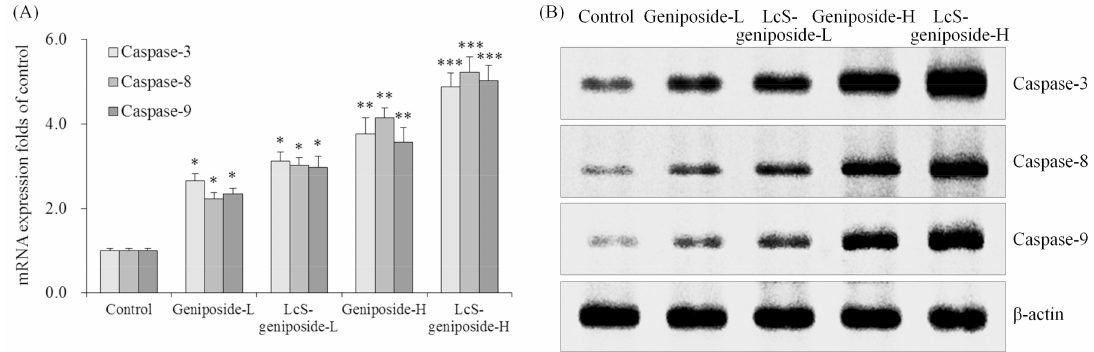
Figure 3. The mRNA ( A ) and protein ( B ) expressions of caspase-3 caspase-8 and caspase-9 in human oral squamous carcinoma HSC-3 cells. * p < 0.05, ** p < 0.01, *** p < 0.001 vs. the control group.